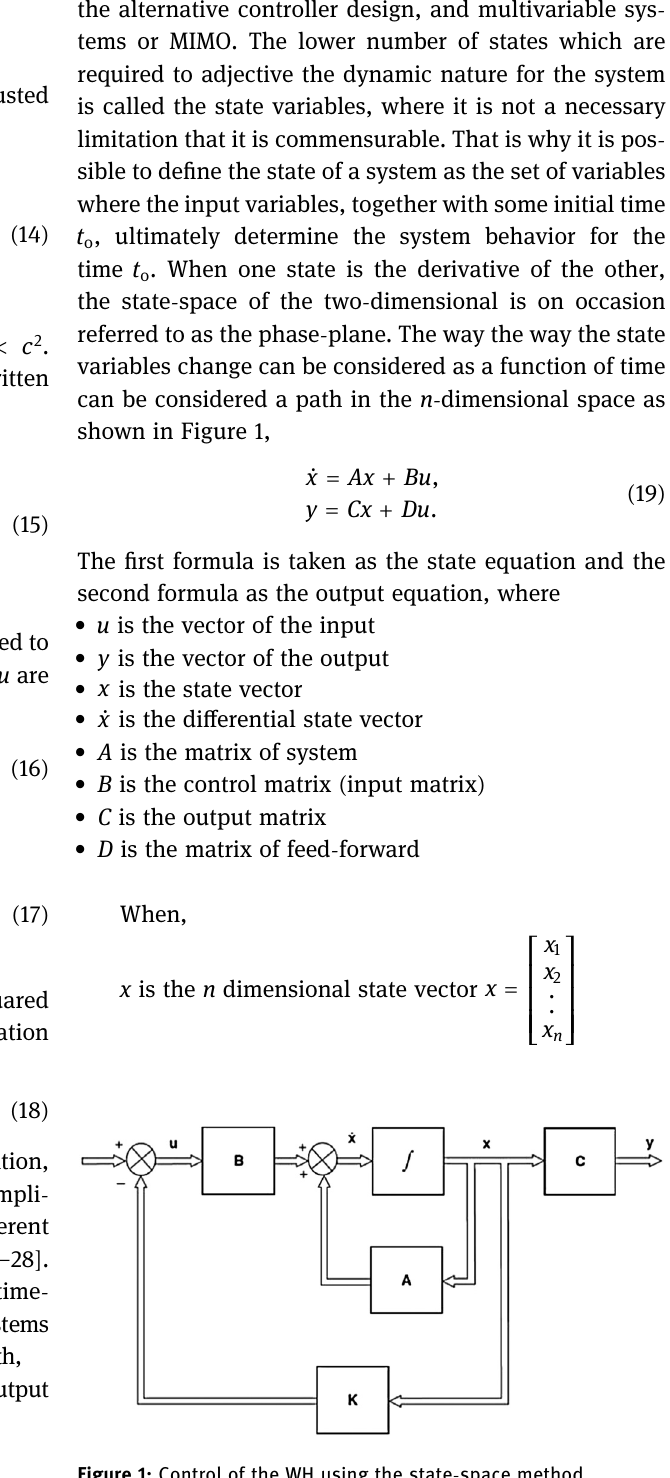
Figure 1: Control of the WH using the state - space